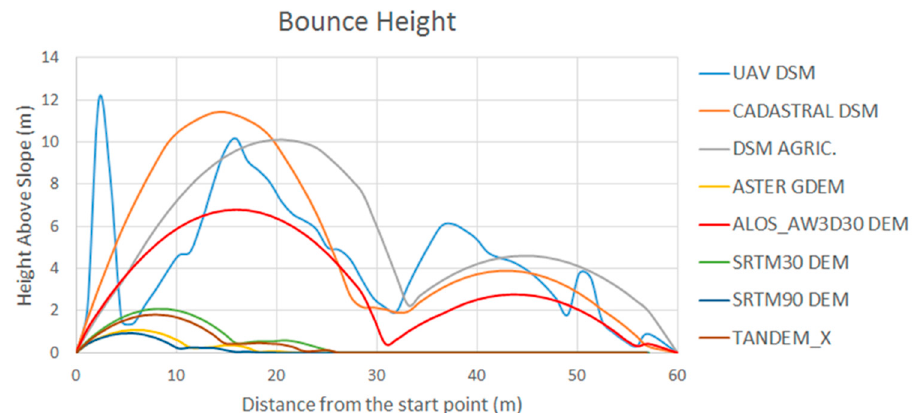
Figure 17. Bounce height for the 2nd slope profile.